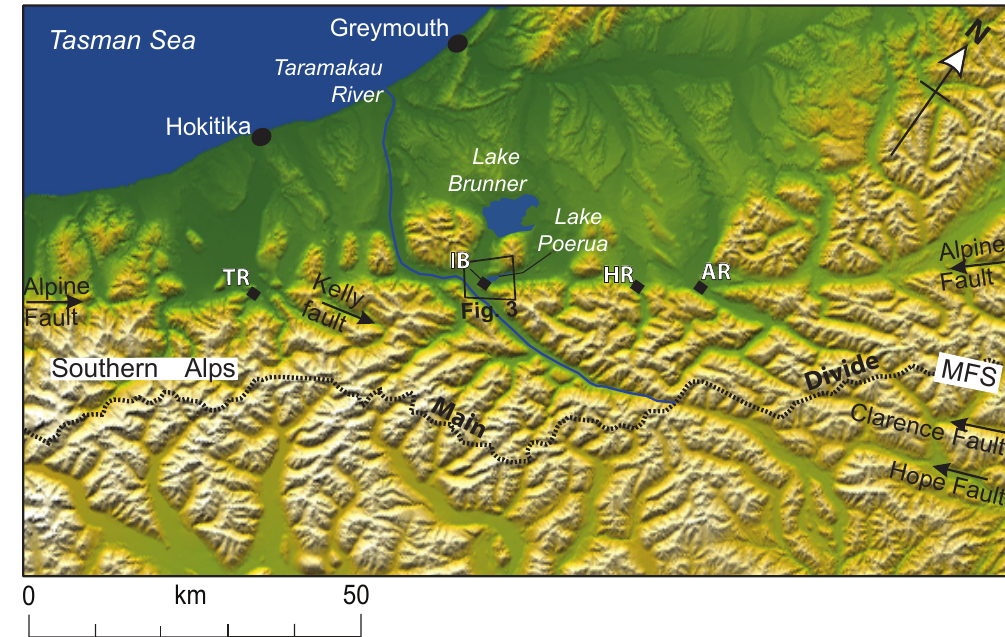
Fig. 2. Colour digital elevation map of central Westland, rotated to emphasise the Alpine Fault. Inchbonnie (IB) and Lake Poerua are located within the small box marked as Fig. 3. In this area, plate motion is transferred to faults of the Marlborough Fault System (MFS). The Taramakau River (blue line) is shown from the Main Divide of the Southern Alps (black dotted line) to the coast. Alpine Fault paleoseismic sites, including Ahaura River (AR) are shown by